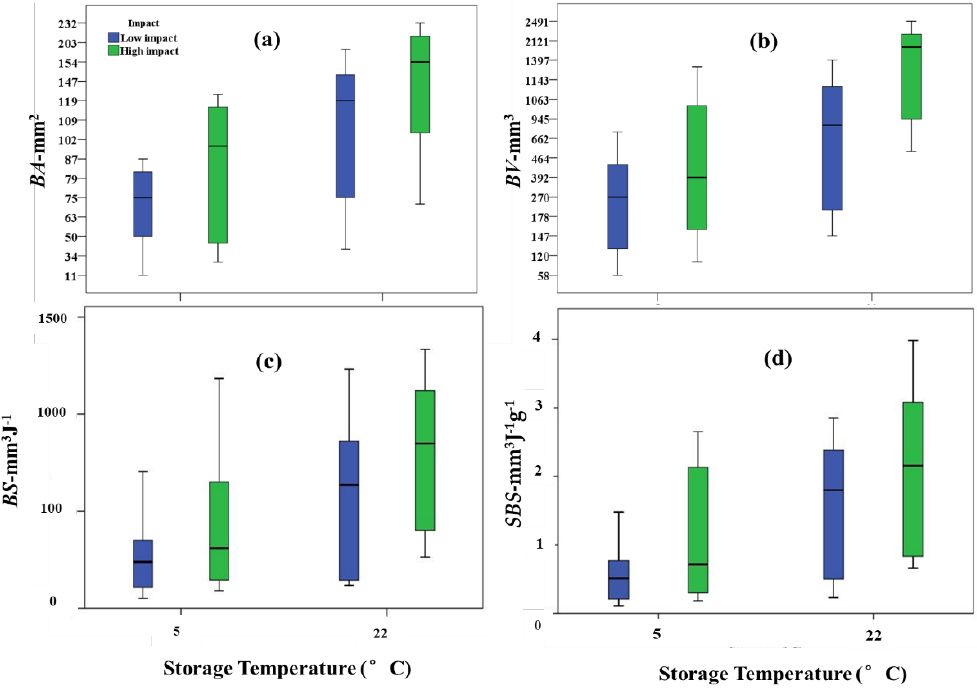
Figure 2. Bruise area ( BA ) ( a ), bruise volume ( BV ) ( b ), bruise susceptibility ( BS ) ( c ), and specific bruise susceptibility ( SBS ) ( d ) of pomegranate fruit impacted at different impact angles (45°, 1.18 J; and 65°, 2.29 J) and stored at 5 °C and 22 °C after 28 days of storage. The data are presented in box plots. Error bars represent the SD of the mean values of two readings per group (treatment).